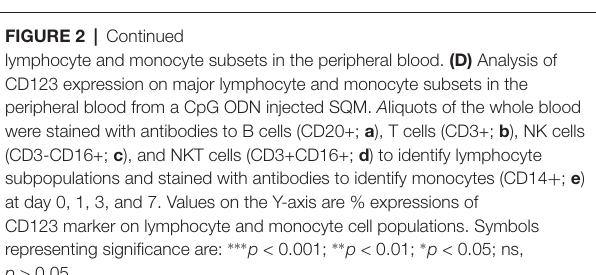
FIGURE 2 | Continued lymphocyte and monocyte subsets in the peripheral blood. (D) Analysis of CD123 expression on major lymphocyte and monocyte subsets in the peripheral blood from a CpG ODN injected SQM. A liquots of the whole blood were stained with antibodies to B cells (CD20+; a ), T cells (CD3+; b ), NK cells (CD3-CD16+; c ), and NKT cells (CD3+CD16+; d ) to identify lymphocyte subpopulations and stained with antibodies to identify monocytes (CD14 + ; e ) at day 0, 1, 3, and 7. Values on the Y-axis are % expressions of CD123 marker on lymphocyte and monocyte cell populations. Symbols representing significance are: ∗∗∗ p < 0.001; ∗∗ p < 0.01; ∗ p < 0.05; ns, p > 0.05.